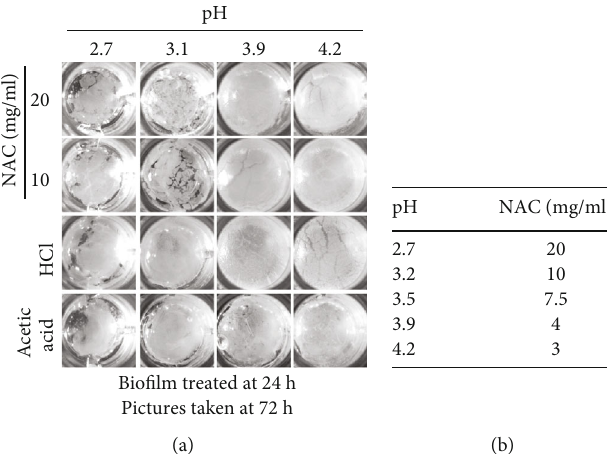
Figure 4: The e ff ects of pH on the ability of NAC to dismantle the bio fi lm. (a) 24 h old bio fi lm was treated with either 20 or 10mg/ml of NAC or HCL or acetic acid at di ff erent adjusted pH to 2.7, 3.1, 3.9, and 4.2, corresponding to the pH range of 20-3mg/ml of NAC. When the pH of the NAC solution for both concentrations is below the pKa (3.24), bio fi lm was disturbed. However, when pH > pKa , the structure of the bio fi lm remained intact. Bio fi lm treated with HCL and acetic acid remained intact at ≥ pH 3.1. When pH further decreased to pH 2.7, bio fi lm treated with both acids became fragile. (b) shows the pH of the NAC solution at the speci fi c concentration of NAC. Three biological replicates were